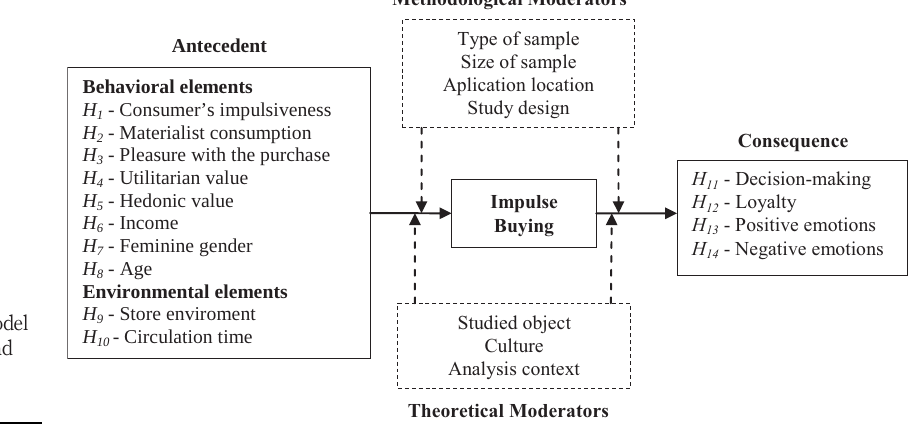
Figure 1. Meta-analytic